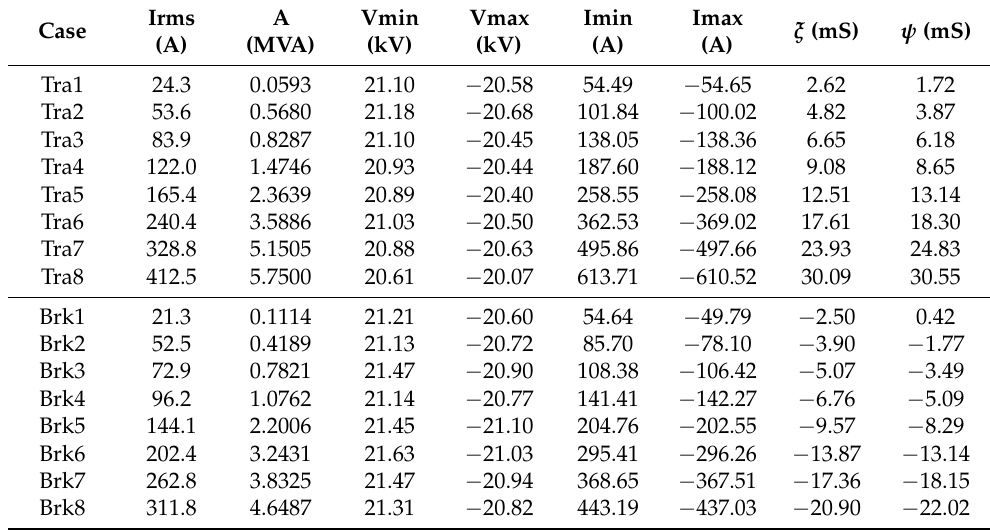
Figure 6. Typical VI trajectories for France (from low to high current intensities, top to bottom): ( a ) tractioning, ( b ) braking. Table 1. VI diagram parameters for Switzerland (case numbering from 1 to 8, following Figure